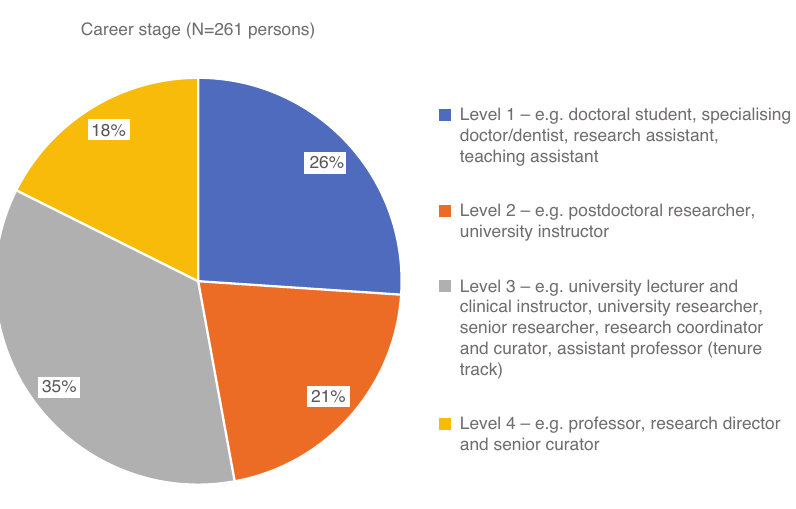
Fig. 3: Respondents by career stage (N=261 persons).